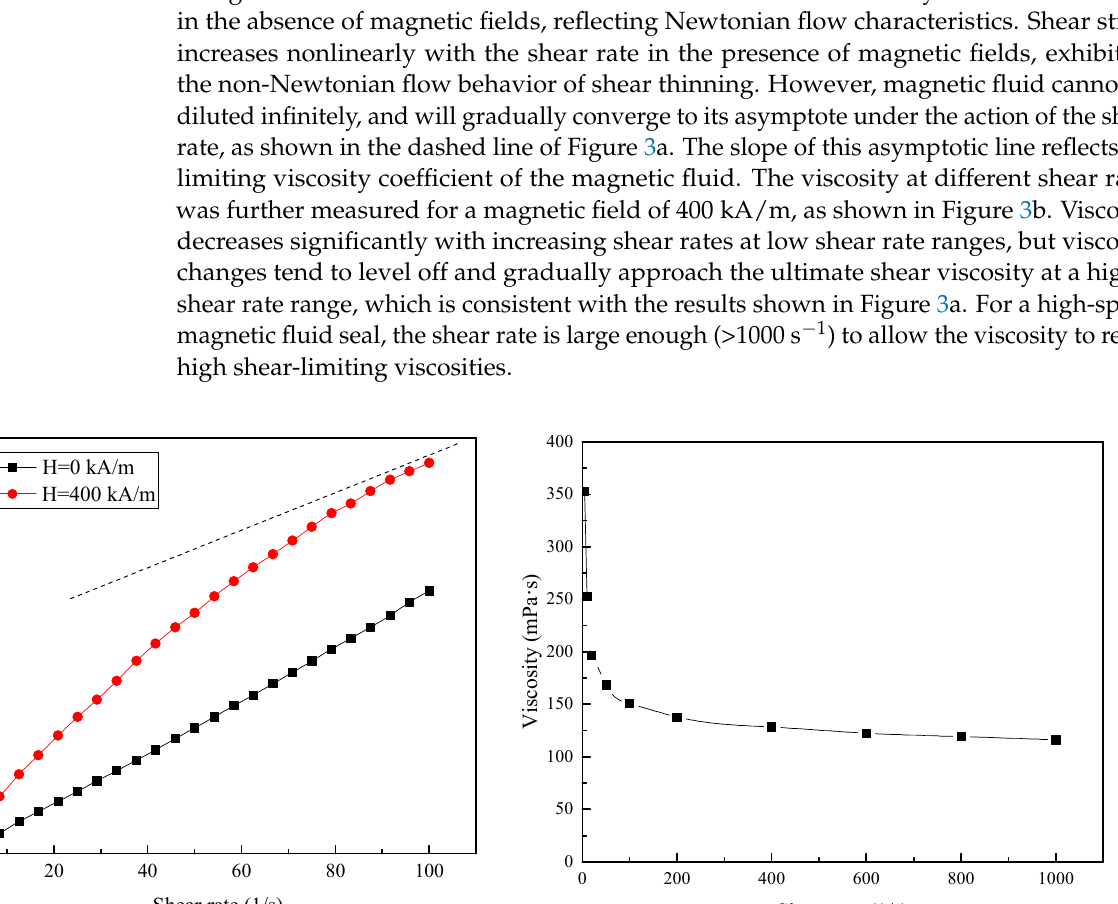
Figure 4. Relationship between the viscosity of the magnetic fluid and the magnetic field strength. Based on the results of Figures 3 and 4, it is clear that the viscosity of the magnetic fluid achieved magnetic saturation and the ultimate shear state under high-speed sealing conditions, due to the sufficiently strong magnetic field and high shear rate. Therefore, the temperature is the key factor affecting the variation in viscosity under high-speed seal- ing conditions, ignoring the influence of the magnetic field and the shear rate. The viscos- ity–temperature curve of diester-based magnetic fluids was experimentally measured at a magnetic field strength of 400 kA/m and a shear rate of 1000 s − 1 . As depicted in Figure 5, viscosity gradually decreases with an increase in temperature, showing a nonlinear rela- tionship, and the decrement becomes slower at higher temperatures.